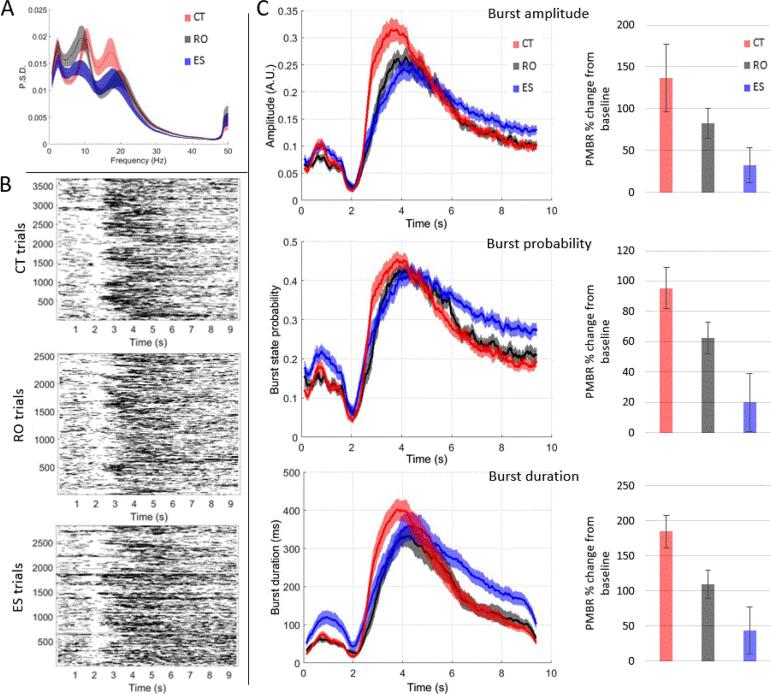
Characteristics of HMM identified task-related bursts. A) Power spectral density of chosen burst state, red for controls (CT), black for recent-onset patients (RO) and blue for established patients (ES). Mean and SEM shown. B) Raster plots of binarised bursts across time per trial. Top plot shows controls, middle plot shows recent-onset patients, bottom plot shows established patients. C) First column: time courses of HMM burst characteristics, top to bottom, amplitude, burst state probability and burst duration. Mean and SEM shown. Second column: Percentage change of the relevant HMM burst characteristic within the PMBR (2.5–4.5 s) relative to the baseline window (6–9 s) for each time course. Mean and CI shown. (For interpretation of the references to colour in this figure legend, the reader is referred to the web version of this article.)